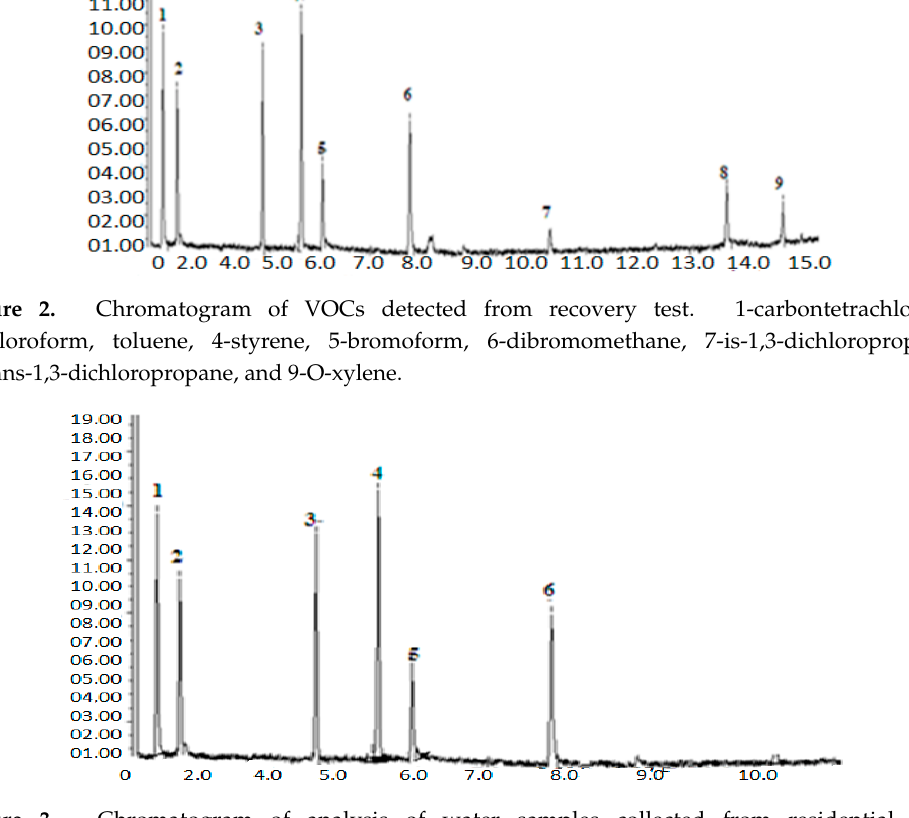
Figure 3. Chromatogram of analysis of water samples collected from residential area. 1-carbontetrachloride, 2-chloroform, 3-toluene, 4-styrene, 5-bromoform, and 6-dibromomethane.